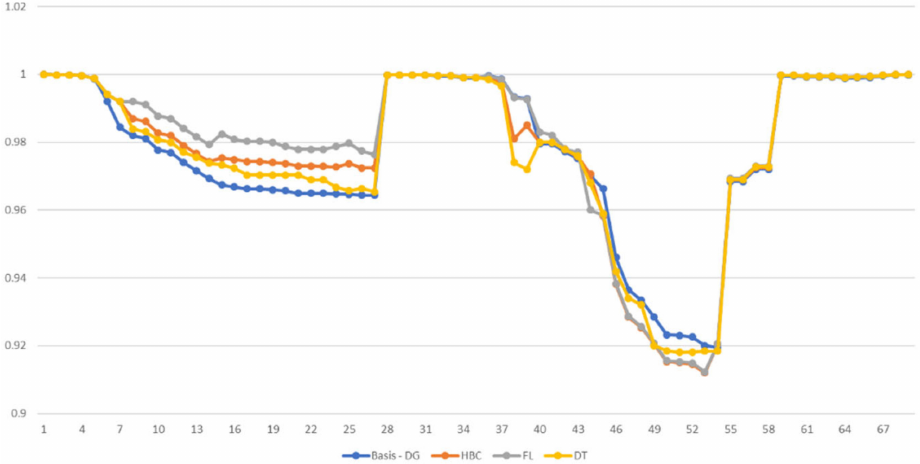
Figure 5. Case of distributed generation. Voltage profile. Base case (blue); Hysteresis Band Control method (orange); control by means of Fuzzy Logic (grey); Decision Trees method (yellow). Table 2. Case without distributed generation: tie-switches of the configuration of the system. Initial HBC FL DT